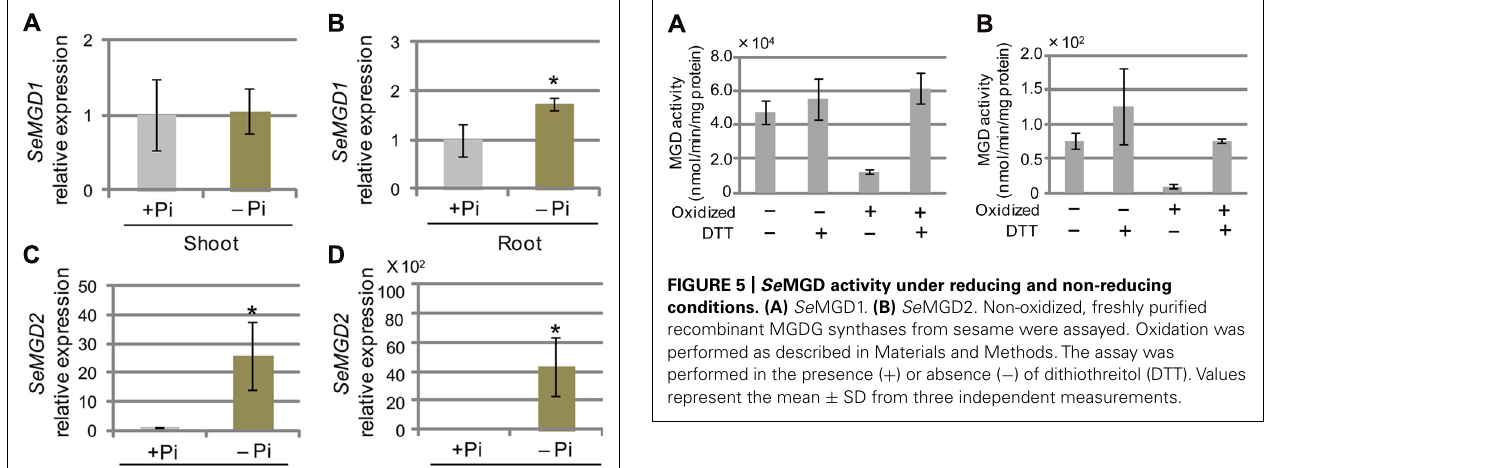
Se MGD1, 18 mol% for Se MGD2) were substantially higher than those required for At MGD1 (0.6 mol%; Dubots et al., 2010).